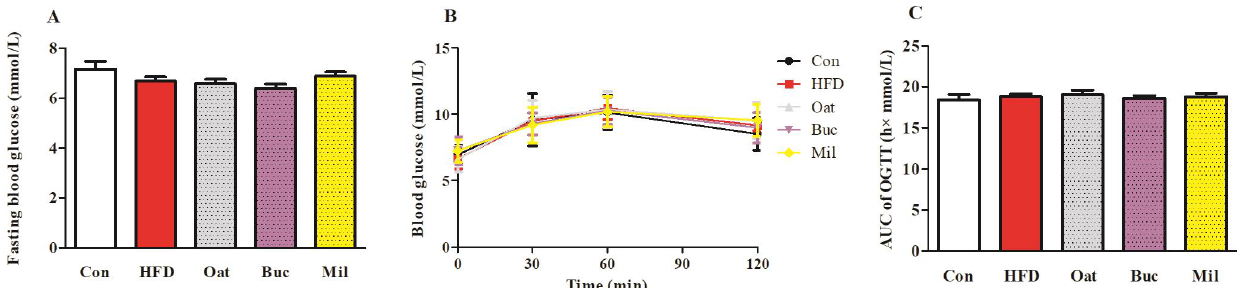
Figure 3. Effect of oats, tartary buckwheat, and foxtail millet supplementation on fasting blood glucose ( A ), OTGG ( B ), and AUC of OGTT ( C ) in high-fat diet fed rats. Con group, a basal diet group; HFD group, a high-fat diet group; Oat group, HFD containing 22% oat group; Buc group, HFD containing 22% tartary buckwheat group; Mil group, HFD containing 22% foxtail millet group; AUC, area under the curve; OGTT, oral glucose tolerance test. Data are presented as the mean ± SD ( n =